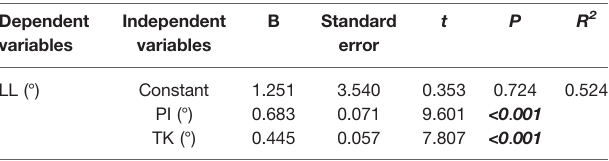
TABLE 3 | Multiple linear regressions.